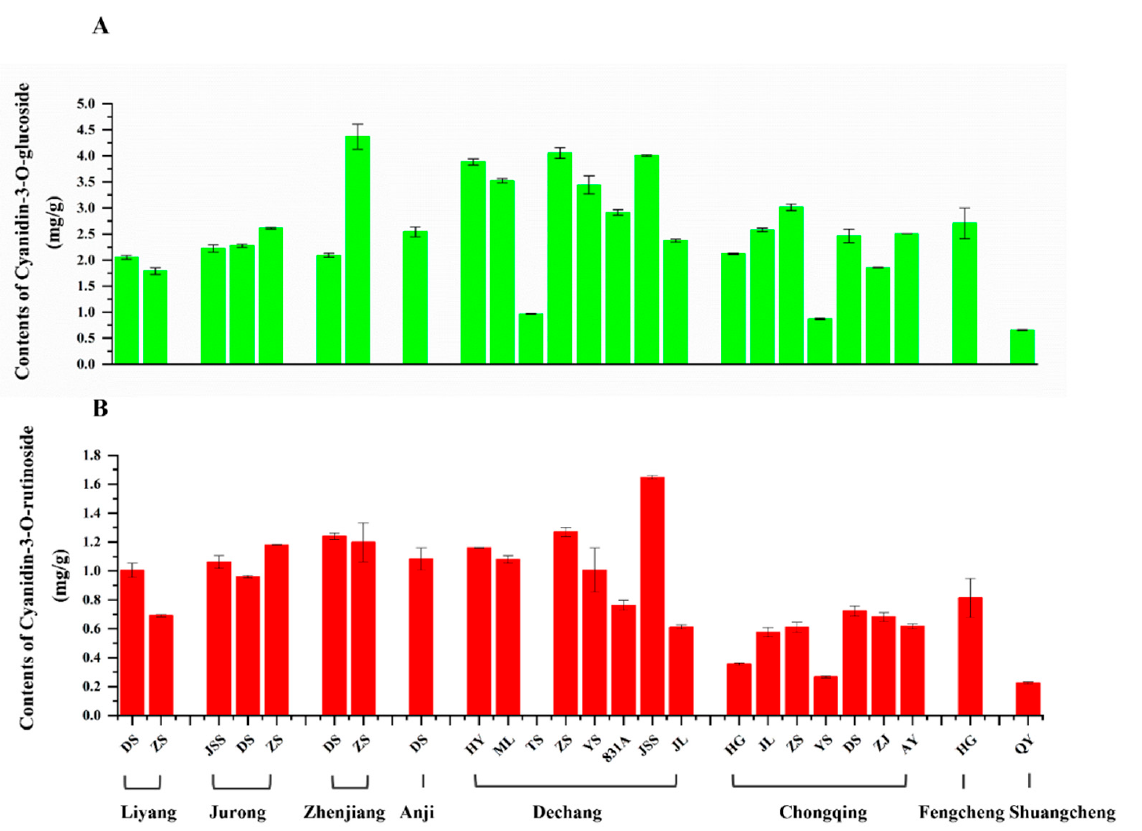
Figure 2. The contents of cyanidin-3- O -glucoside ( A ) and cyanidin-3- O -rutinoside ( B ) in mulberry fruits among varieties from different areas in China.